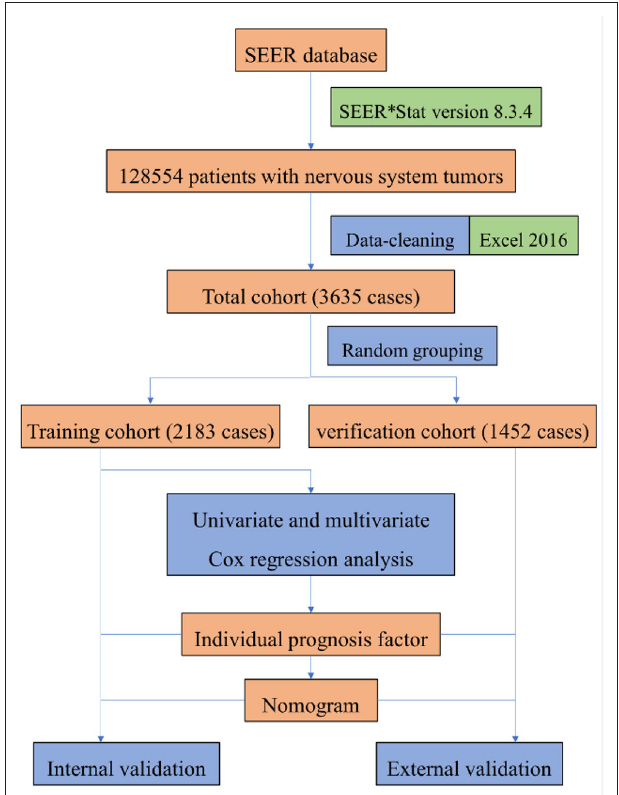
FIGURE 1 | The procedure of building a nomogram for patients with glioblastoma. Firstly, we derived patients with nervous system tumors from the SEER database, then selected patients with glioblastoma, and eliminated the invalid data. Secondly, univariate and multivariate Cox regression analysis were performed to obtain individual variables affecting prognosis. Thirdly, individual variables were used to construct nomogram that predicted the prognosis of patients, then internal and external validation were